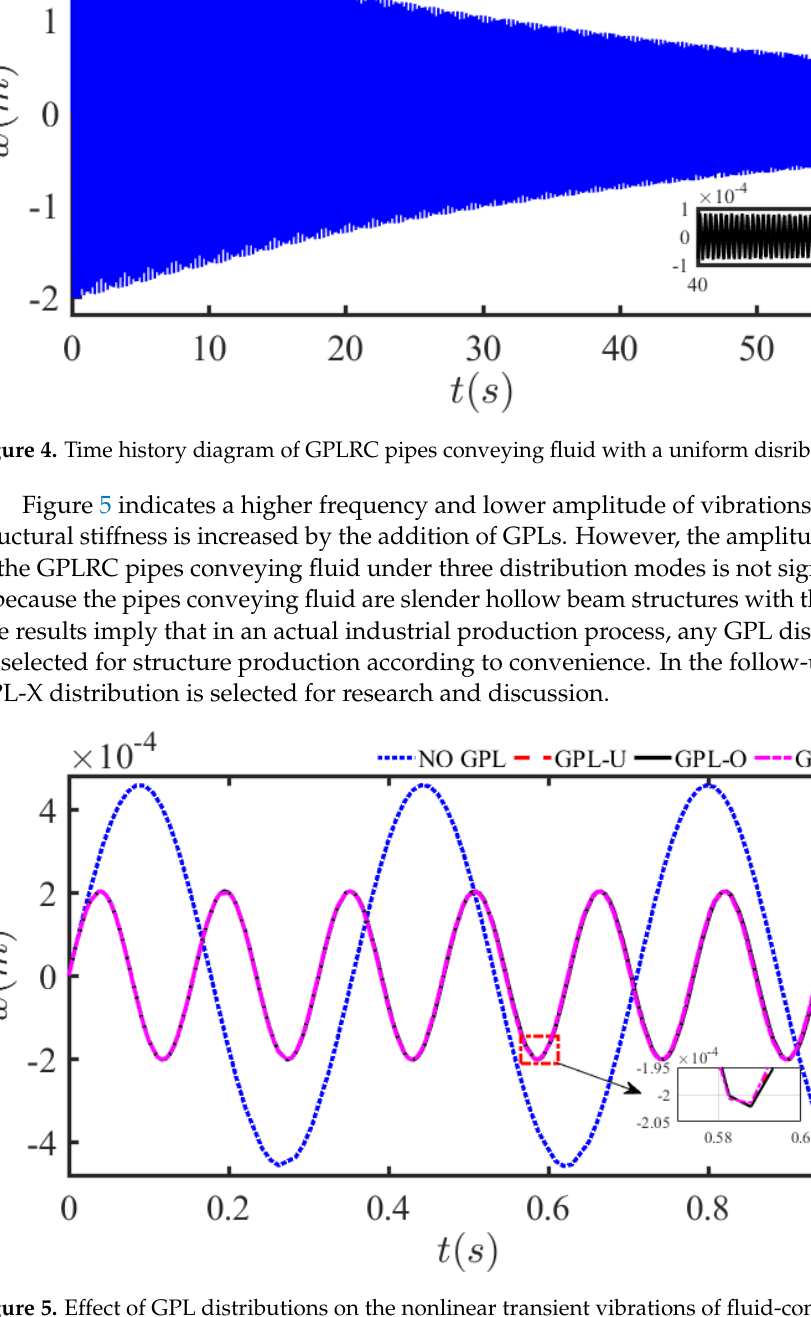
Figure 5. Effect of GPL distributions on the nonlinear transient vibrations of fluid-conveying pipes.